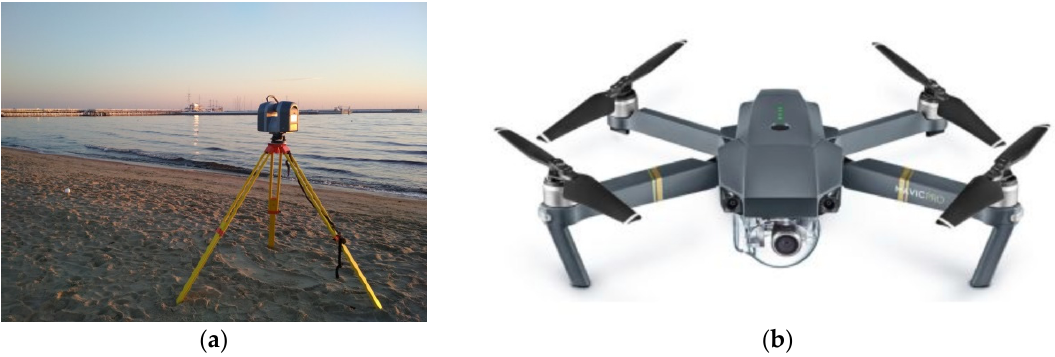
Figure 6. Laser scanner ( a ) and unmanned aerial vehicle (UAV) DJI Mavic Pro ( b ) used for geospatial modeling of the beach in Sopot.